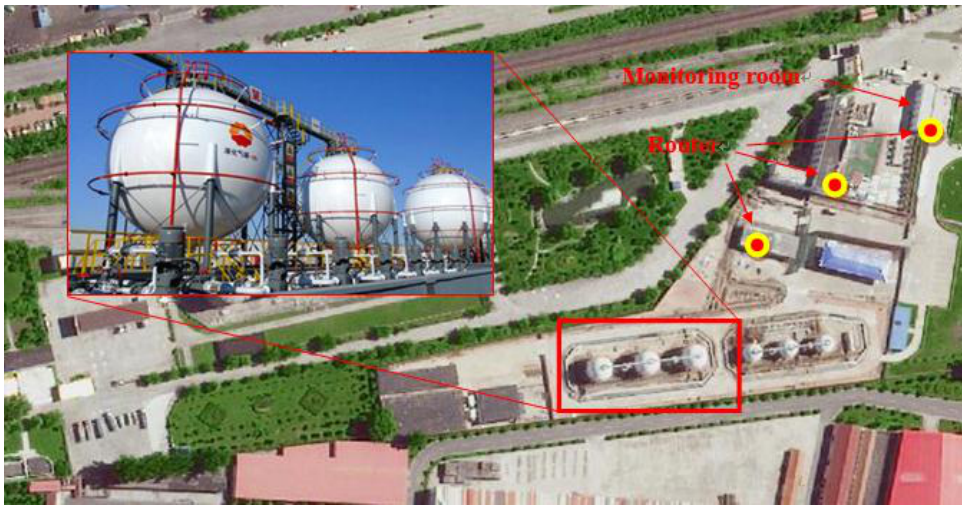
Figure 18. Project overview.